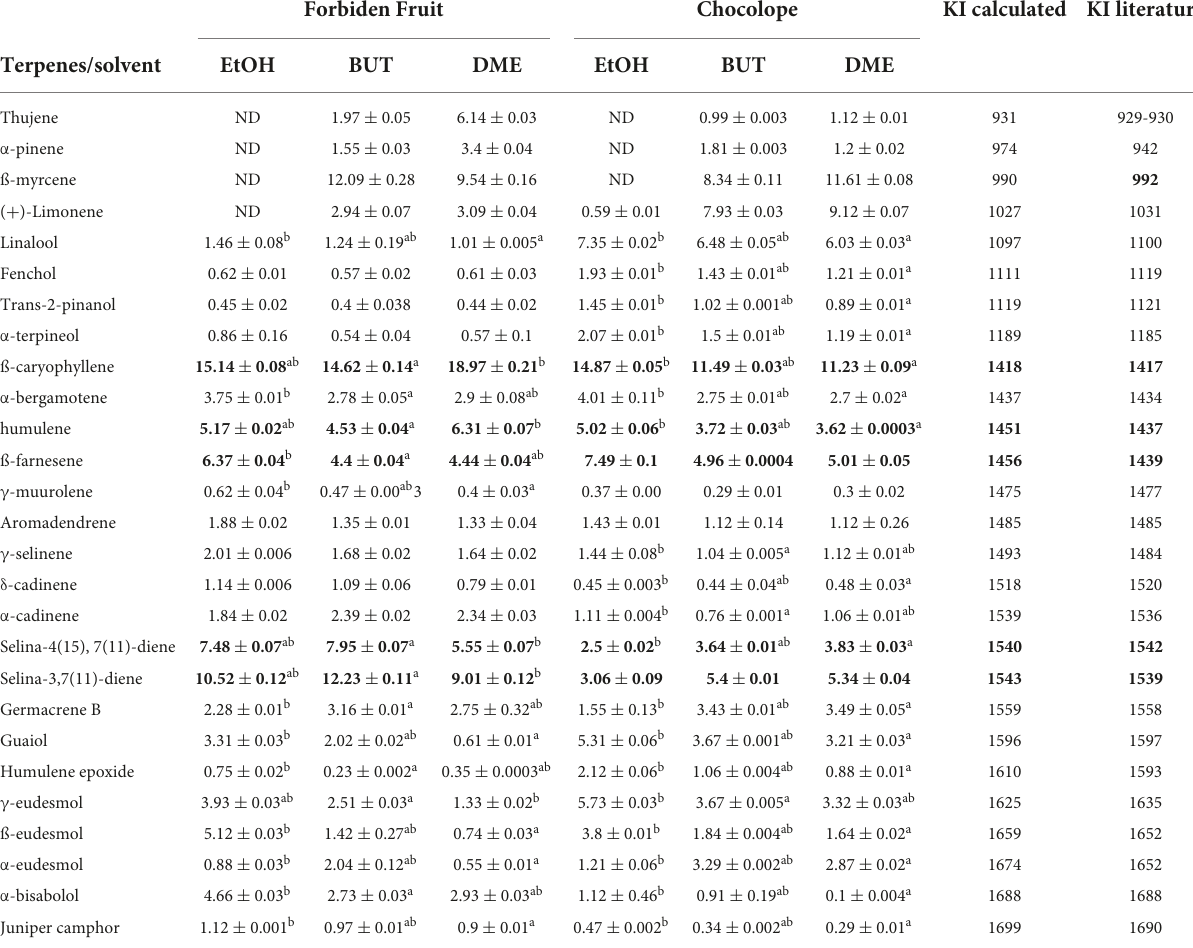
TABLE 2 Relative ratio (%) of terpenes in cannabis extracts prepared by different